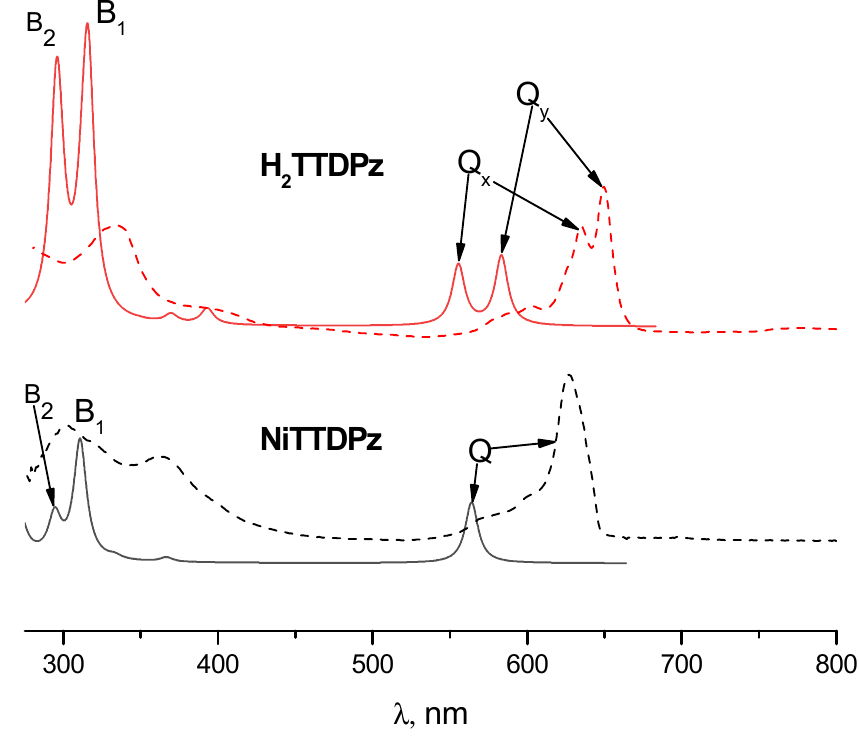
Figure 6. Calculated TDDFT electronic absorption spectra for H 2 TTDPz and NiTTDPz molecules (solid lines) and the corresponding experimental spectra in DMSO solutions (dashed lines).